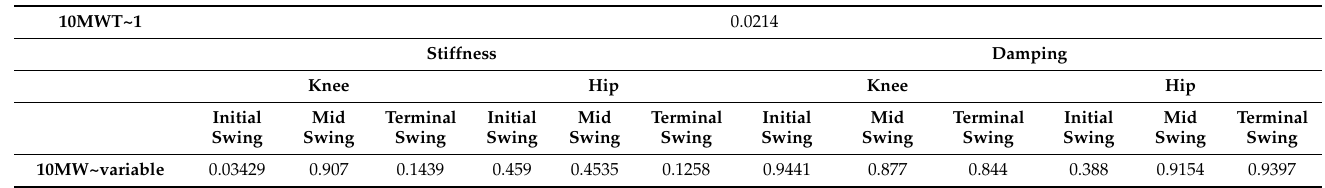
Figure 4. Results of the analysis of the best variable to explain walking ability with aggregated data over all ambulatory patients (each point indicates the mean of the three assessments for every patient). The red line indicates the regression line. The relationships between ( A ) 10MWT [m/s] and the variable knee stiffness initial swing (b = − 0.04, p -value = 0.03, R 2 = 0.71) and ( B ) TUG [s] and knee stiffness initial swing (b = 3.38, p -value = 0.02, R 2 = 0.80) are represented. MWT: meter-walk test; TUG: timed up and go test. Table 4. p -values of the regression model analysis for 10MWT and each parameter.